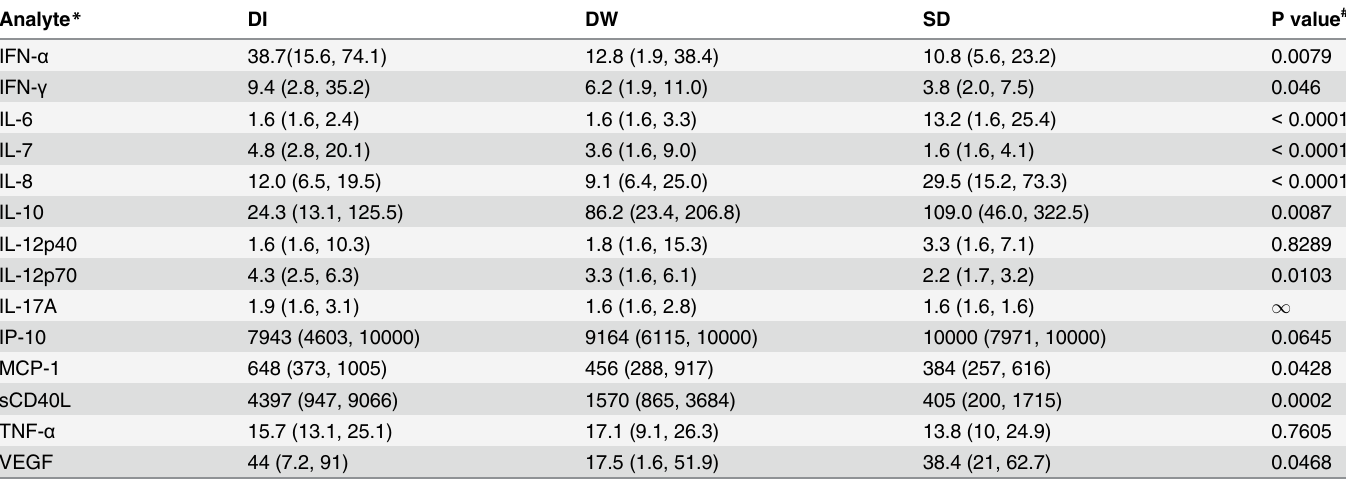
Table 4. Quantitation of inflammatory mediators in dengue patients with different disease severities. Analyte